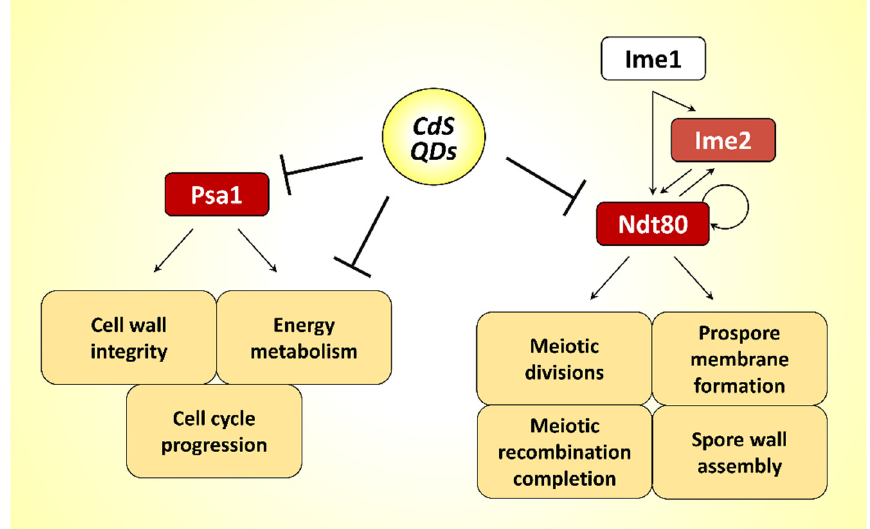
Figure 9. Schematic diagram illustrating the hypothetical mechanism of action of the CdS QDs in gametogenesis.